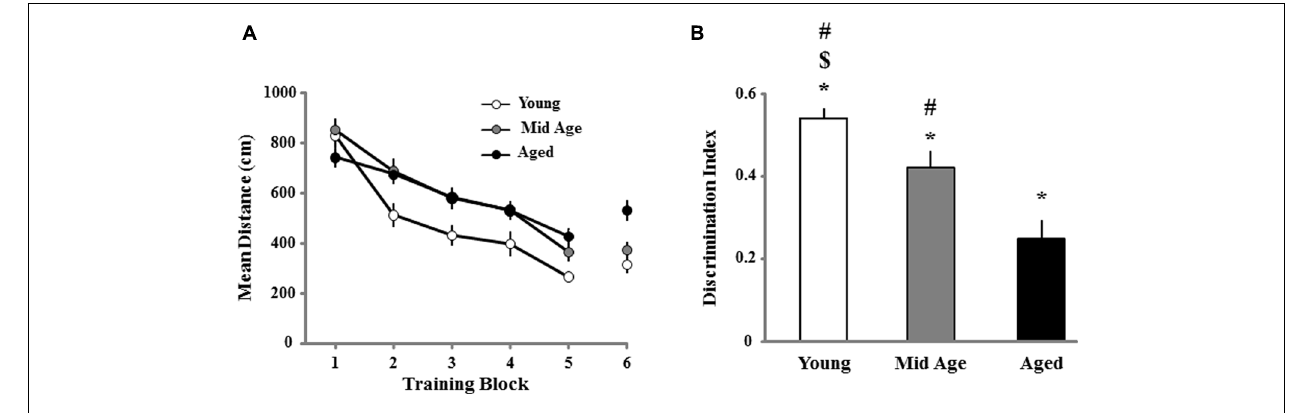
FIGURE 3 |Animal’s performance on the spatial discrimination task. (A) The mean path length to find the escape platform during the spatial discrimination task in the water maze. Data represents the mean distance traveled ( ± SEM) per training block in the spatial discrimination task for young (open circle, n = 36), middle-age (Mid Age, gray circle, n = 44), and